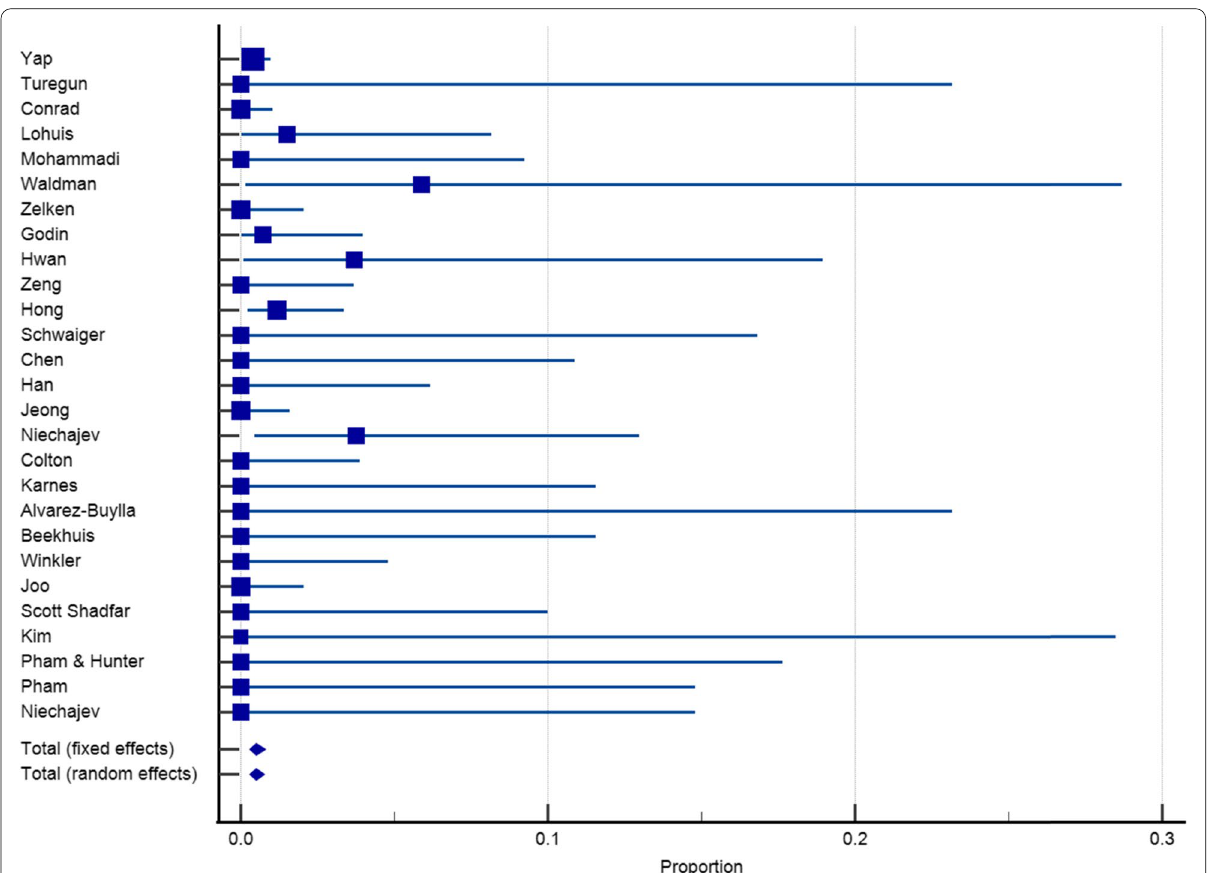
Fig. 7 Over correction rates reported for synthetic materials in both fixed and random-effects